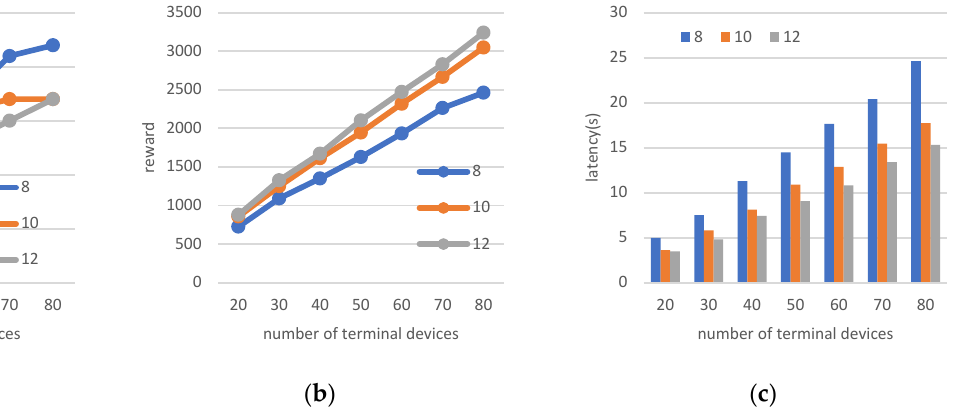
Figure 8. ( a ) Number of selected edge nodes: ( b ) energy cost; ( c ) latency when changing the number of terminals and node processing capacity.